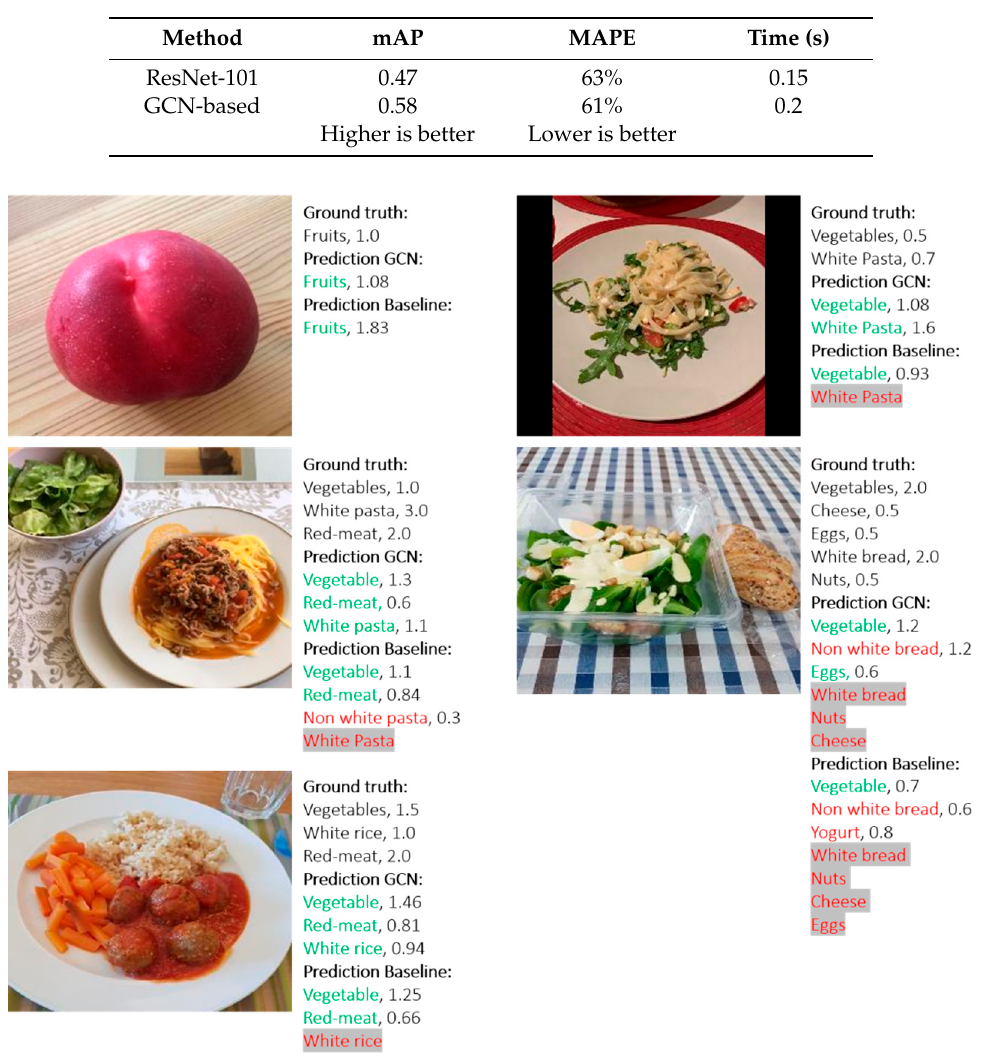
Figure 4. Example results of the GCN-based algorithm. Green indicates correct prediction and red indicates incorrect prediction. Red with gray background indicates missing prediction.